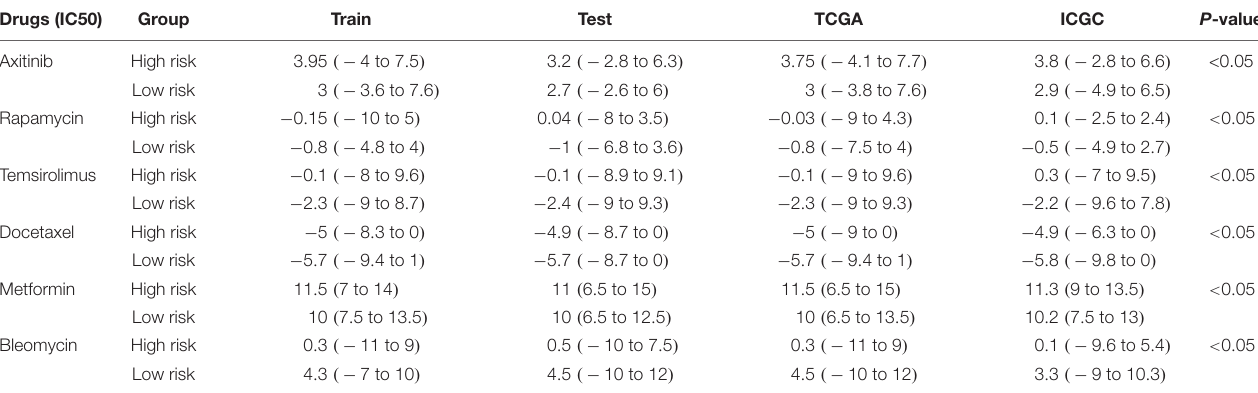
FIGURE 6 | The relationship of ARGP risk group with CTLA4, LC3 expression in different data sets. (A) The differential expression of CTLA4 in the training set, test set, TCGA set, and ICGC set, respectively. (B) The differential expression of LC3 in the training set, test set, TCGA set, and ICGC set, respectively. TABLE 2 | The relationship of ARGP risk group with small molecule drug therapy response in different data